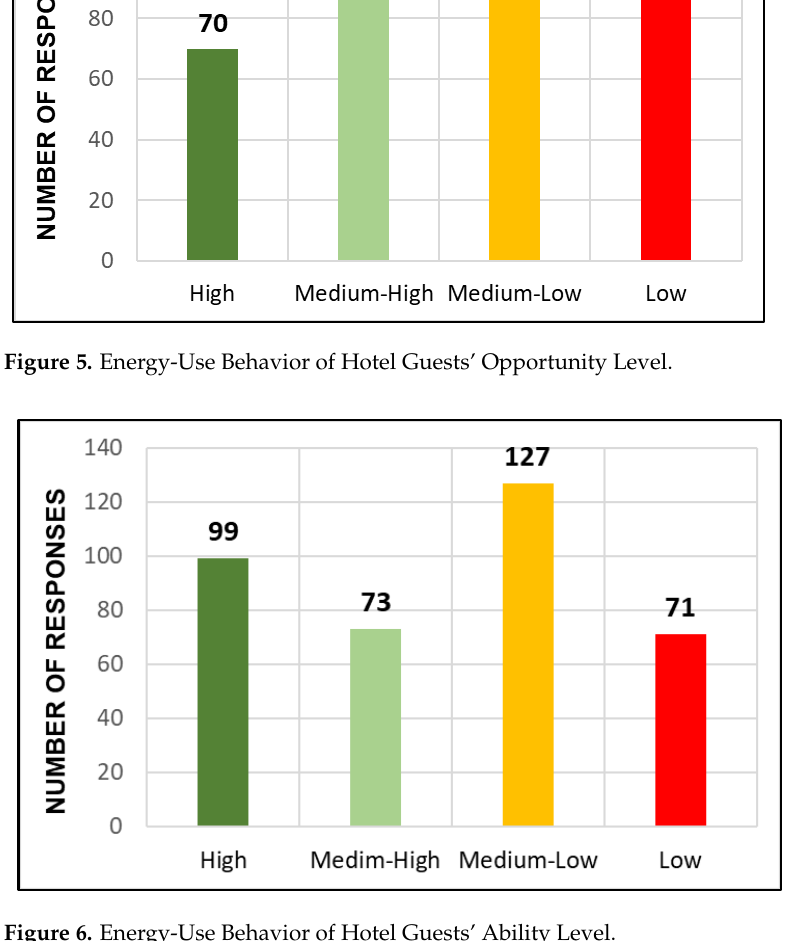
Figure 5. Energy- Use Behavior of Hotel Guests’ Opportunity Level .